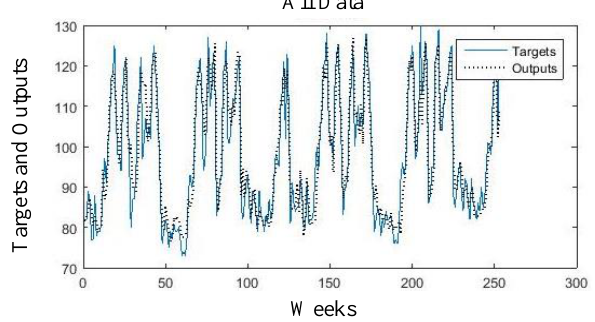
Fig. 15. Comparison of targets and outputs for DWTNN